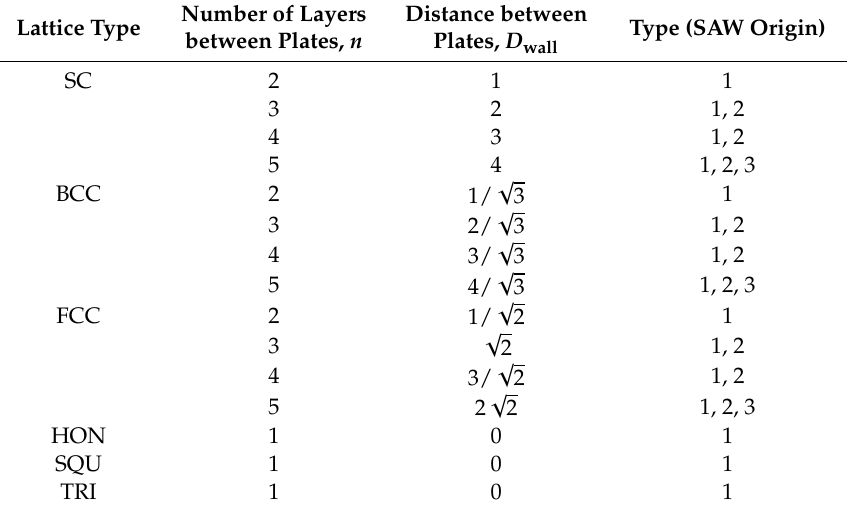
Table 1. Regular lattices studied in three dimensions (simple cubic (SC), body centered cubic (BCC) and face centered cubic, (FCC)), and in two dimensions (honeycomb (HON), square (SQU) and triangular (TRI)). Also shown are the number of layers, n , and the distance, D wall , between the confining plates and the di ff erent SAW Types (points of origin). Inter-plate distance is measured in units of the SAW step length. Number of Layers Distance between Lattice Type Type (SAW between Plates, n Plates, D wall